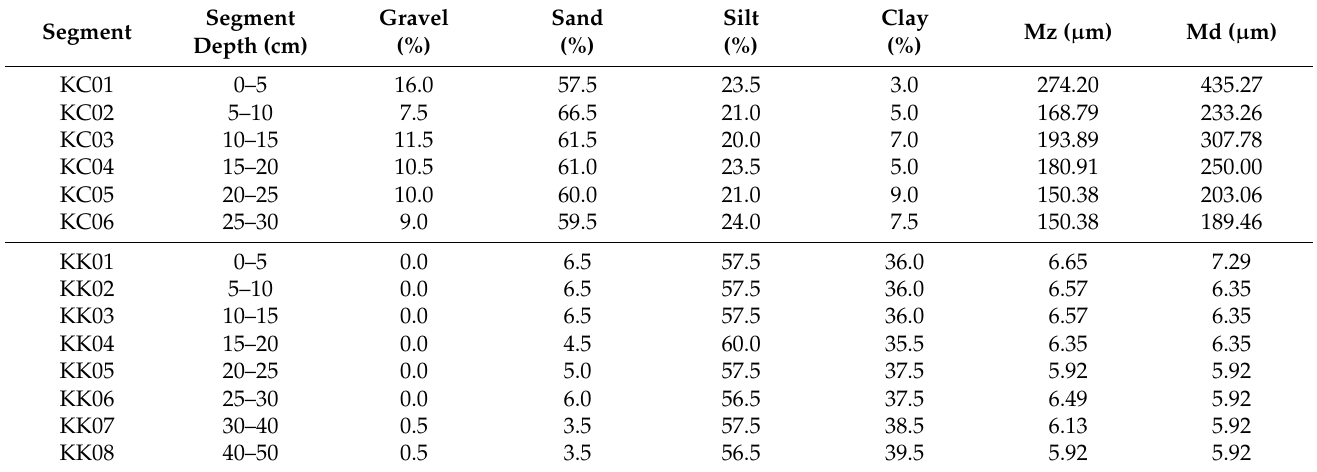
Table 3. Grain size distribution in sediment at the KC and KK sampling stations [22]; Mz, mean size; Md,